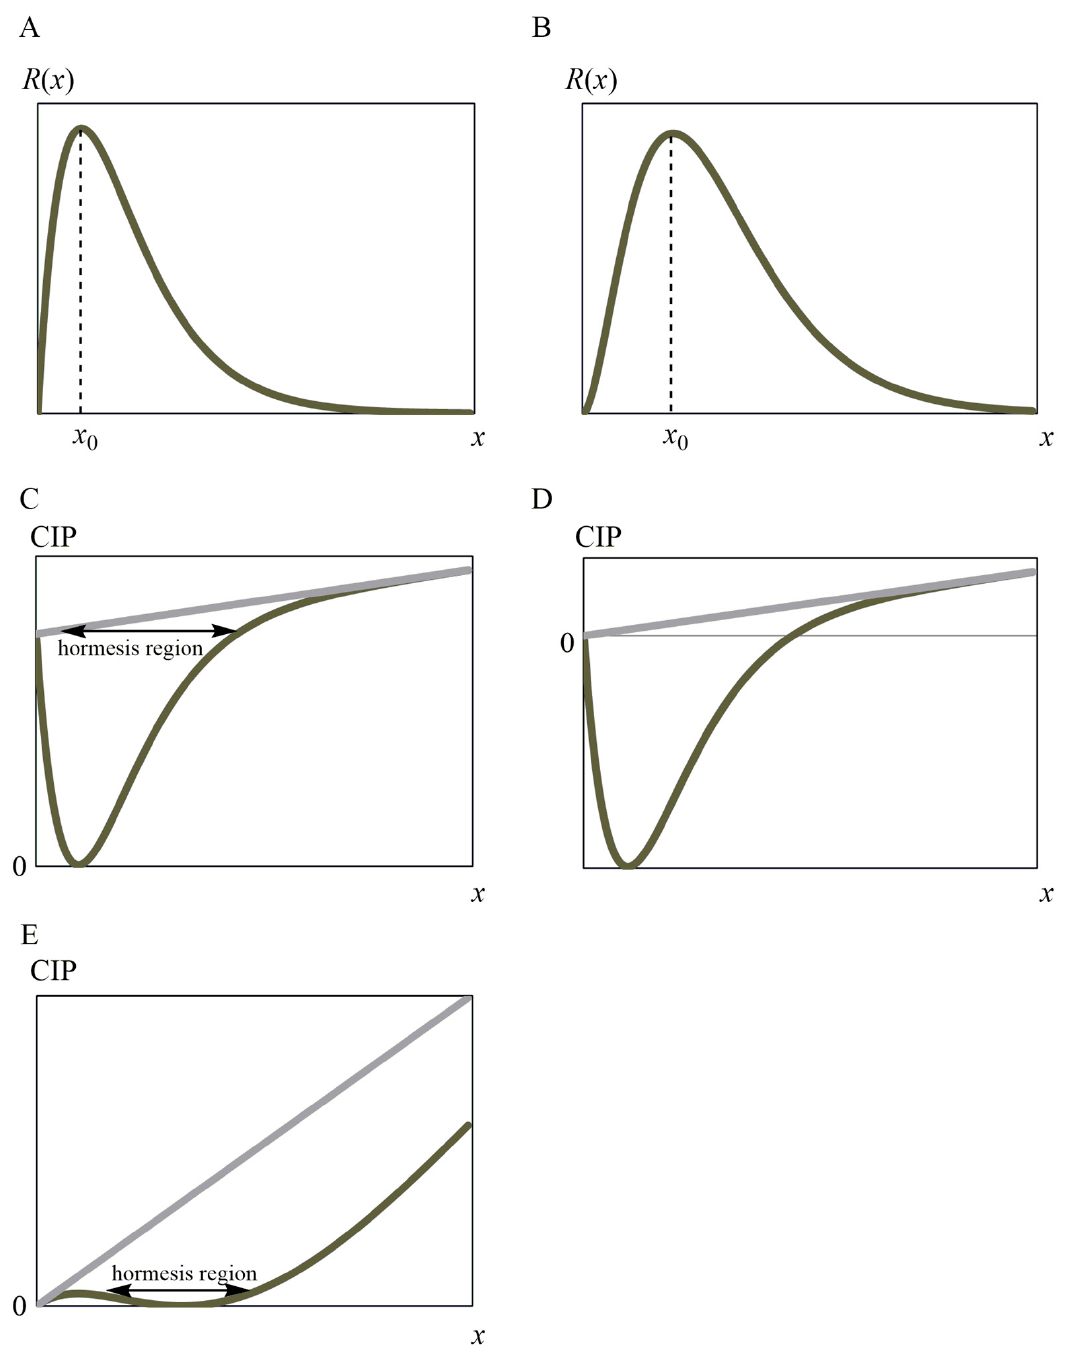
Figure 1. Graphs of R ( x ) and cancer incidence probability (CIP). These graphs were rewritten from the reference [31]. The radiation dose is defined as x . ( A , B ) The radiation dose at which R ( x ) reaches a maximum is defined as x 0 . ( A ) R ( x ) having a single point of inflection at x > x 0 . The graph of R ( x ) is hunchback-shaped. ( B ) R ( x ) having one point of inflection for 0 < x < x 0 and another for x > x 0 . The graph of R ( x ) is mountain-shaped. ( C – E ) The black line indicates the graph of CIP considering R ( x ). The gray line indicates LNT. CIP = LNT − R ( x ). The two-way arrows indicate the hormesis region [31]. ( C ) The graph of CIP using R ( x ), which has a hunchback-shaped graph ( A ). CIP involves factors other than radiation (e.g., reactive oxygen species). ( D ) The virtual graph of CIP using R ( x ), which has a hunchback-shaped graph ( A ). CIP involves only radiation. If R ( x ) of ( A ) is used, CIP mathematically has negative values, and it is not real. ( E ) The graph of CIP using R ( x ), which has a mountain-shaped graph ( B ). CIP involves only radiation.